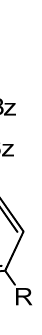
Figure 32. Arene–metal bond interaction in a titanium complex.